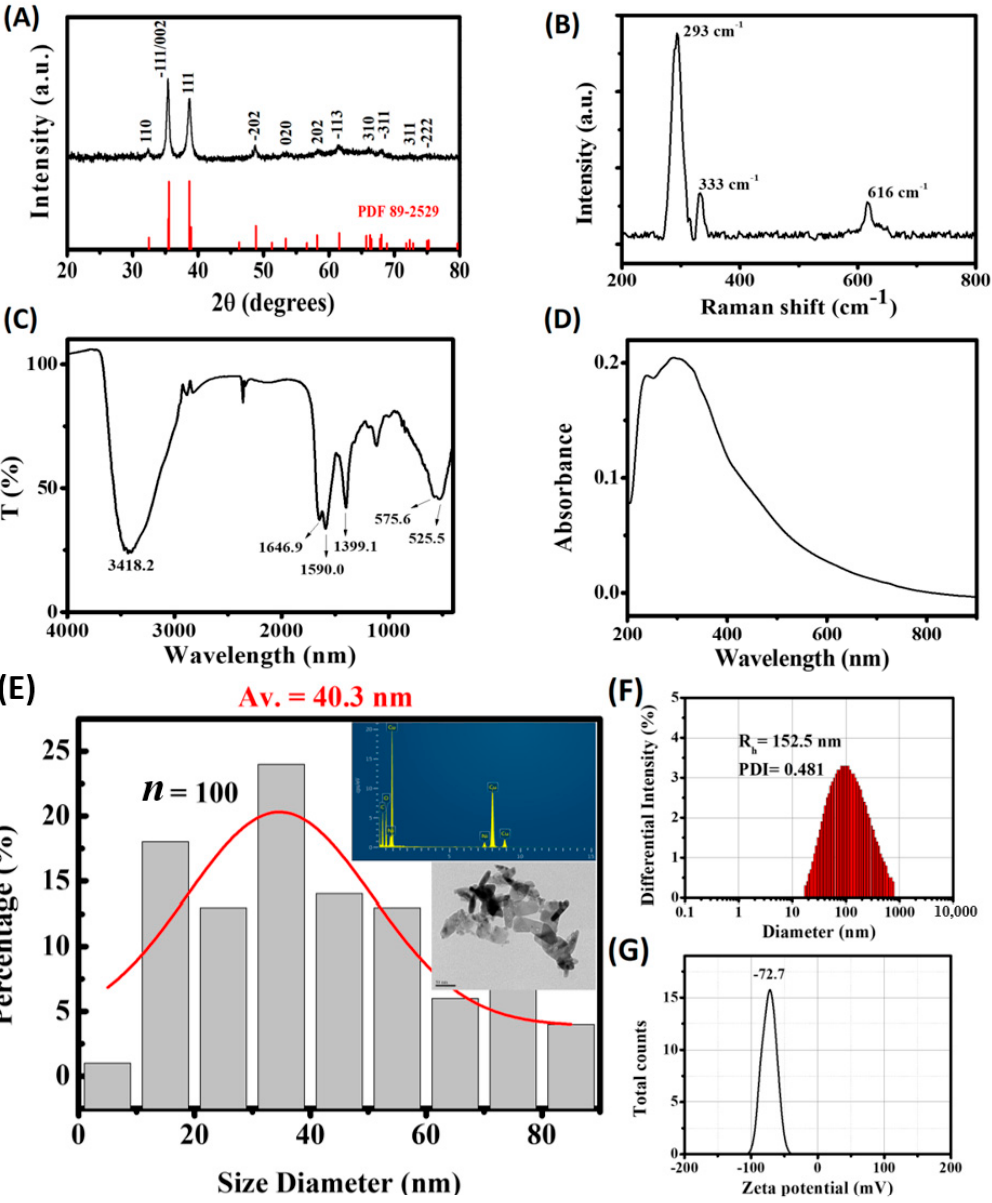
Figure 1. Analysis of physical properties of copper oxide nanoparticles. ( A ) X-ray diffraction (XRD) analysis; ( B ) Raman spectrum; ( C ) Fourier-transform infrared (FTIR) spectrum; ( D ) UV-Vis absorption spectrum; ( E ) Transmission electron Microscopy (TEM) observation and energy-dispersive X-ray spectroscopy (EDS); ( F ) Dynamic light scattering (DLS) analysis; ( G ) Zeta potential measurement.